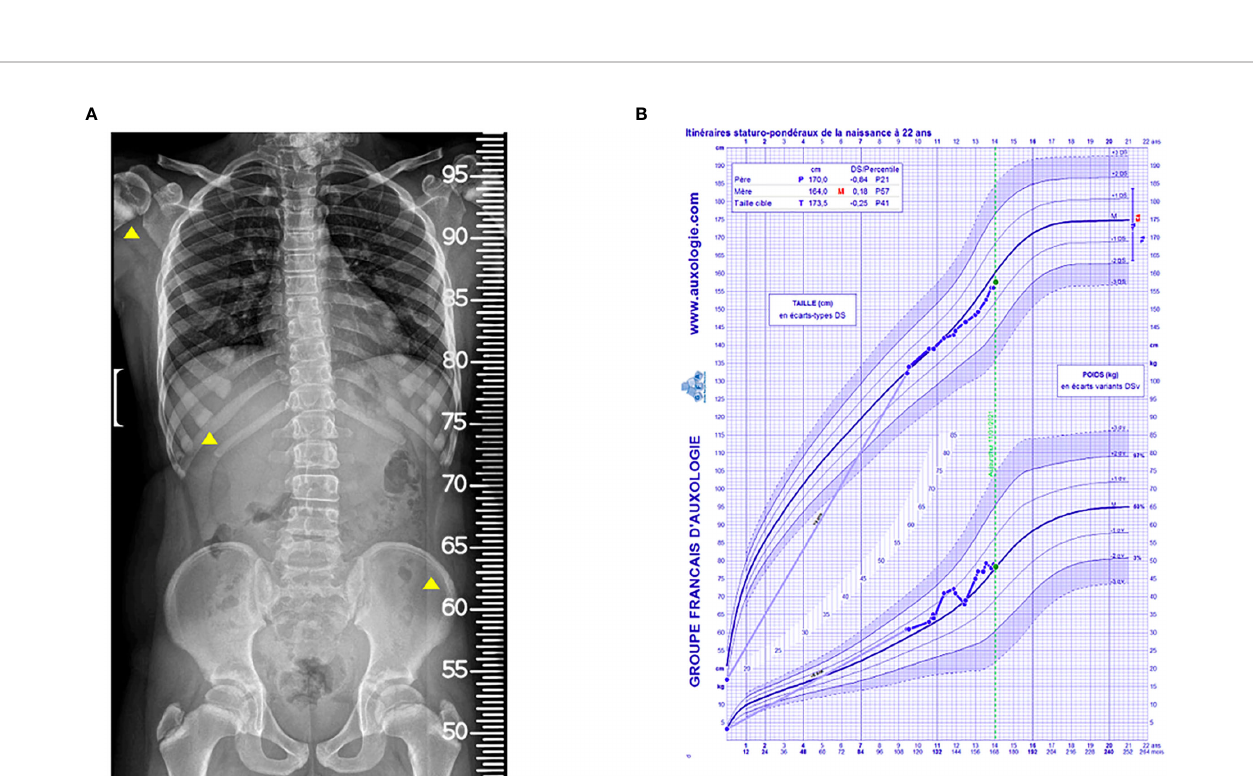
FIGURE 5 | Spine, thoracic and hip radiographic view done by EOS and growth chart. (A) The radiograph was done after 2 years of the 2 nd course of denosumab showing sclerotic bands at ribs, hips and shoulders. (B) Evolution of growth.